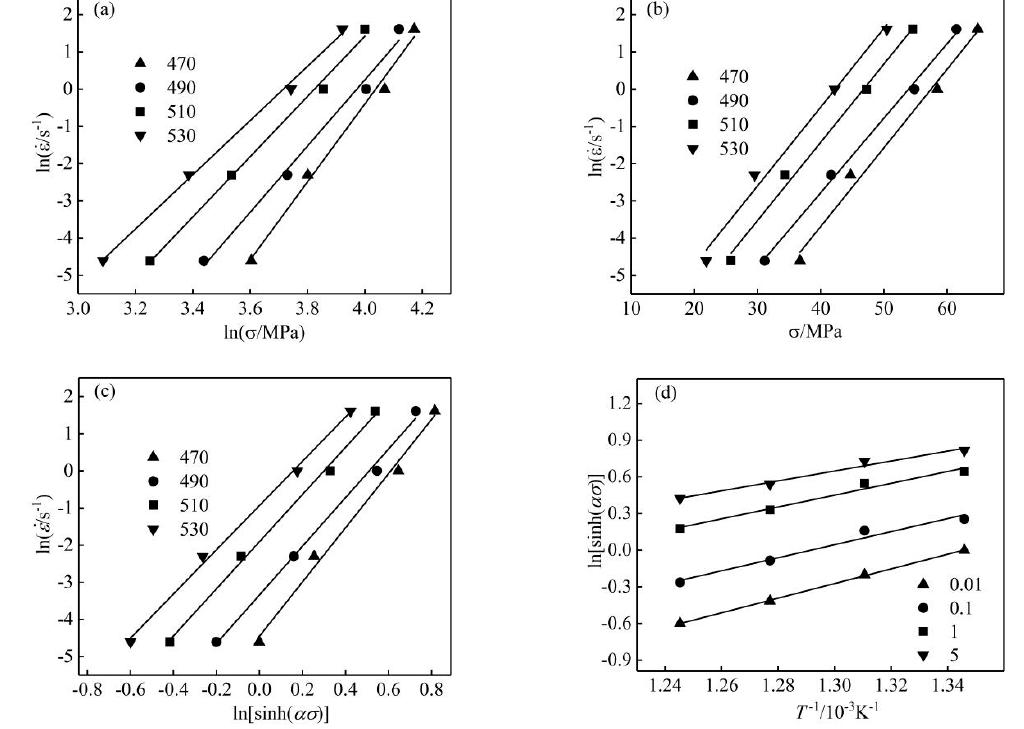
. ε . ε . ε -ln σ ; ( b ) ln - σ ; ( c ) ln -ln[sinh( ασ )];